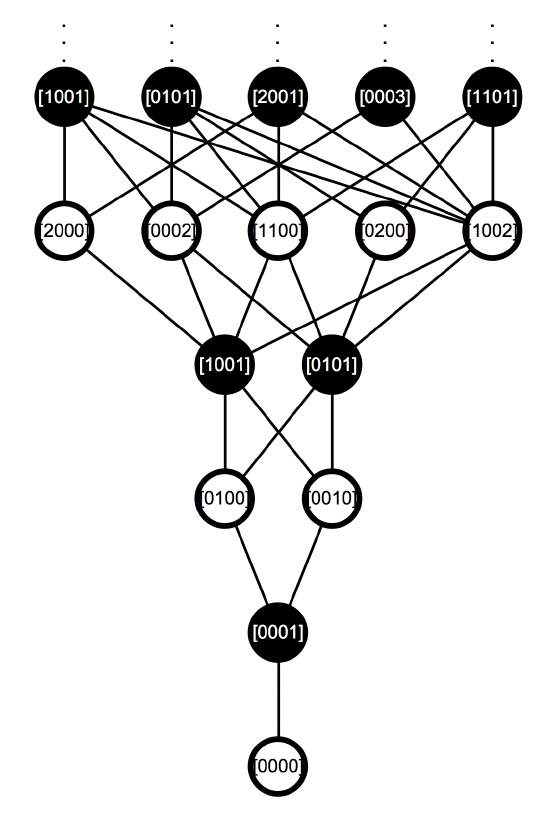
Figure 1 . Adynkra Diagram for 9D minimal scalar